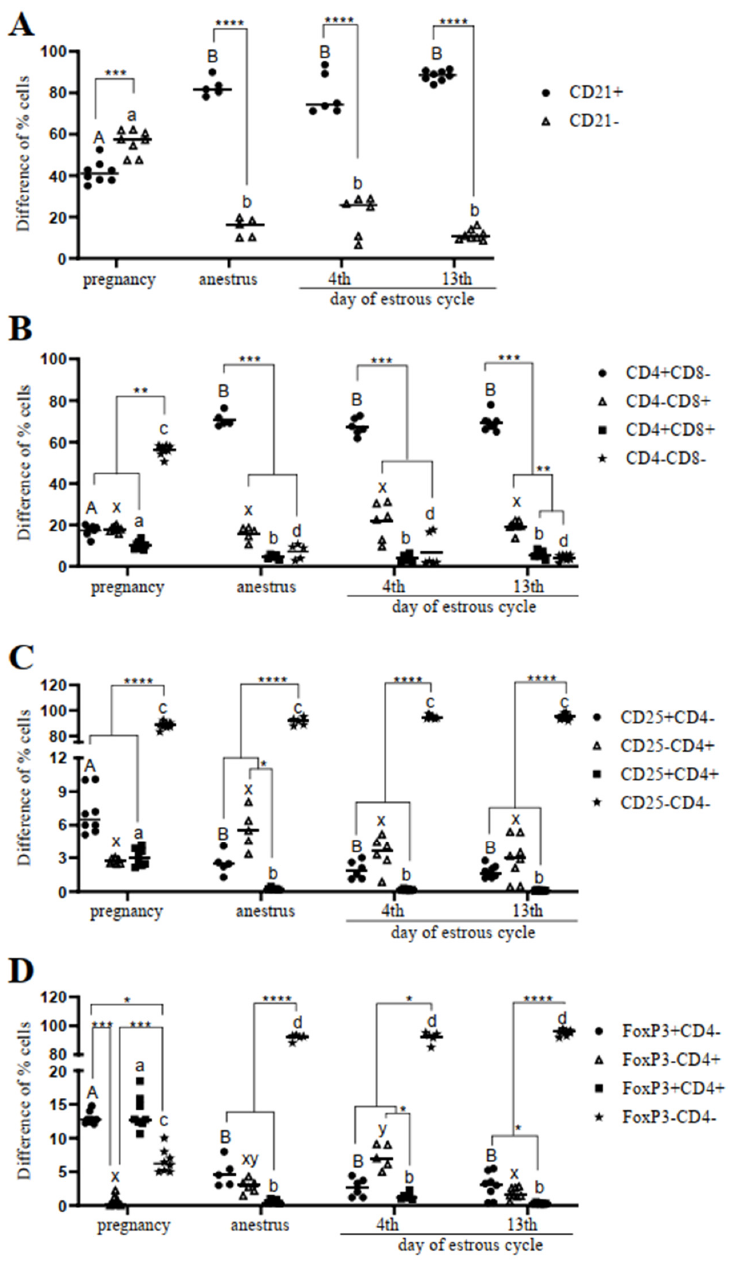
Figure 1. Percentages of positive cells: CD21 ( A ), CD4 and CD8 ( B ), CD25 and CD4 ( C ), and FoxP3 and CD4 ( D ) gated from total lymphocytes. Each dot represents one individual hind and means ± SEM (standard error of the mean) are presented. Statistical differences were analyzed with two-way analysis (ANOVA) of variance followed by Tukey’s post hoc test. The significance levels between gates are: * p < 0.05; ** p < 0.01, *** p < 0.001, and **** p < 0.0001 inside one experimental group. Different letters indicate statistical differences ( p < 0.05) between the experimental reproductive stages.